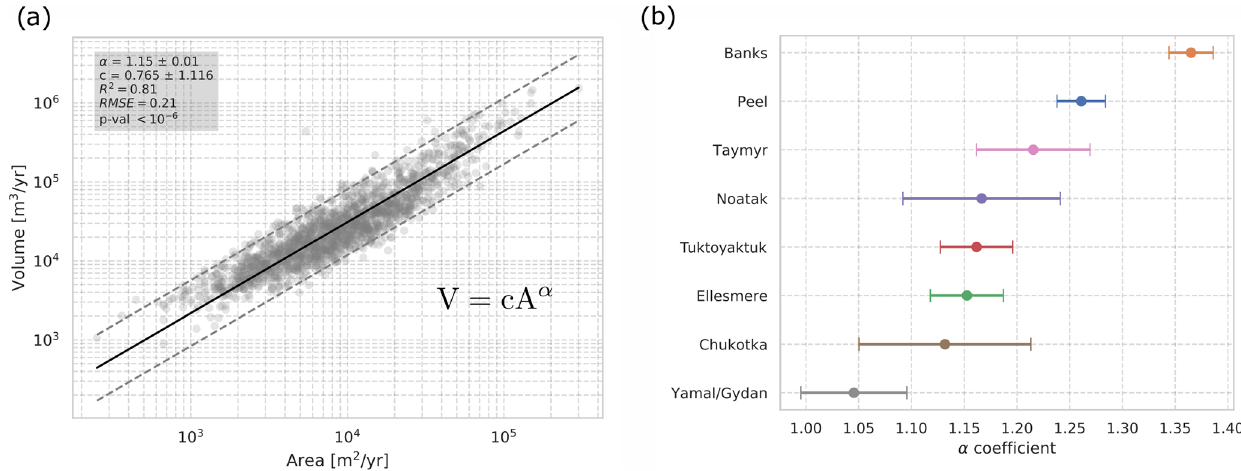
Figure 6. Area-to-volume scaling laws for RTS in the set of study sites. (a) shows the total dataset with all study sites combined. We found an exponential scaling exponent of α = 1 . 15 ± 0 . 01. (b) shows the computed values of the scaling exponent, α , for each site individually with the estimated standard deviation. A large variation between 1.05 and 1.37 is